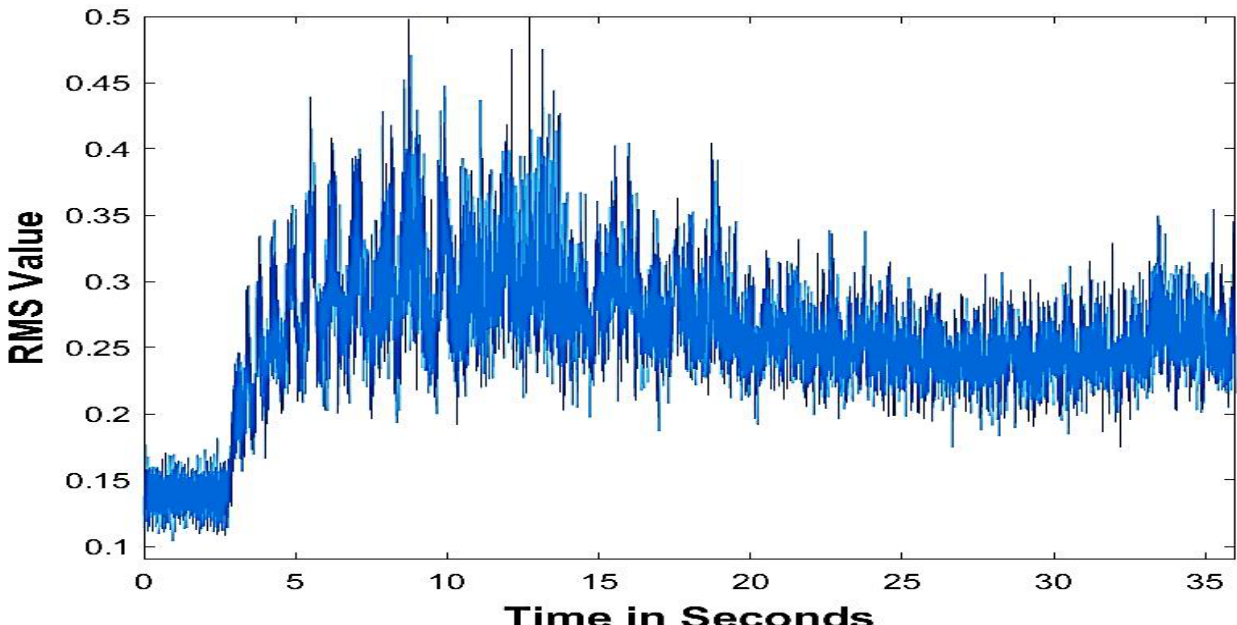
Figure 2. AE signal at depth of cut = 1.5 mm and feed = 0.25 mm/rev, work piece: cast iron.